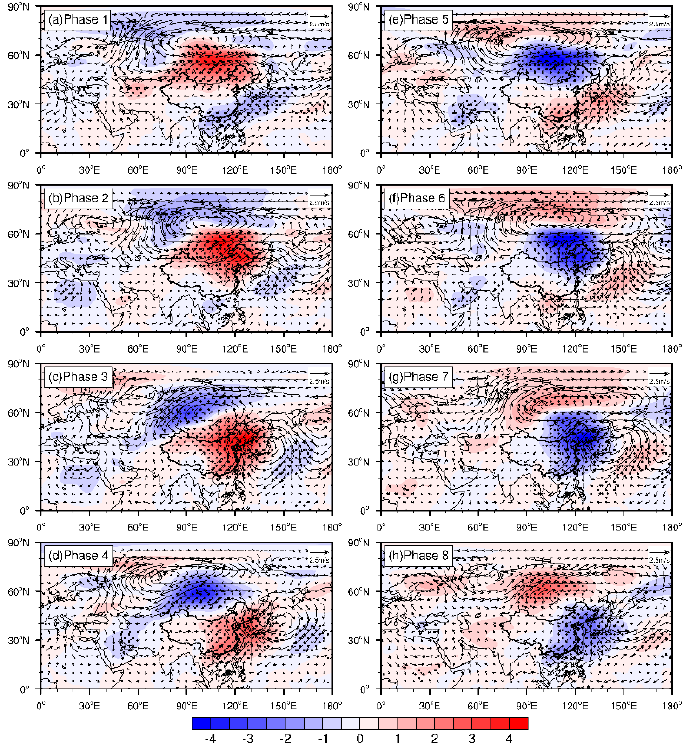
Figure 4. Phase evolution of 10–30 d filtered 925 hPa temperature (shading; unit: °C) and 850 hPa wind (vector; unit: m/s) of LECEs (( a – h ), dotted area passes the 95% significance level). The phase evolution of the 500 hPa vorticity and SLP for LECEs is shown in Figure 5. The negative vorticity anomaly locates near Novaya Zemlya in the early stage of cooling (phases 1–2), and the negative vorticity anomaly expands in phases 3–4 and moves south- eastward to the Ural Mountains, which represents the development of UBH; by this time, the Baikal region is controlled by the positive vorticity anomaly, and, in its downstream, an anticyclonic anomaly exists stably, whereas a “ − + − ” wave train was formed from the Ural Mountains to the Sea of Okhotsk, and the center of the wave train moves southeastward while intensifying. The positive anomaly of SLP locates in West Siberia, and then gradually expands and controls most of China at phase 6. The SH situates more southward and more eastward, and the center of the positive vorticity anomaly moves to 120 ◦ E, corresponding to the formation and maintenance of the Northeast Cold Vortex (NECV), which is favorable for cold air to invade China from the west of low pressure. The negative vorticity anomaly over the Sea of Okhotsk tends to be favored for the cold vortex stagnant in NE-N. The range of the positive anomaly in the SLP shrinks at phase 7; Northeast Asia and the